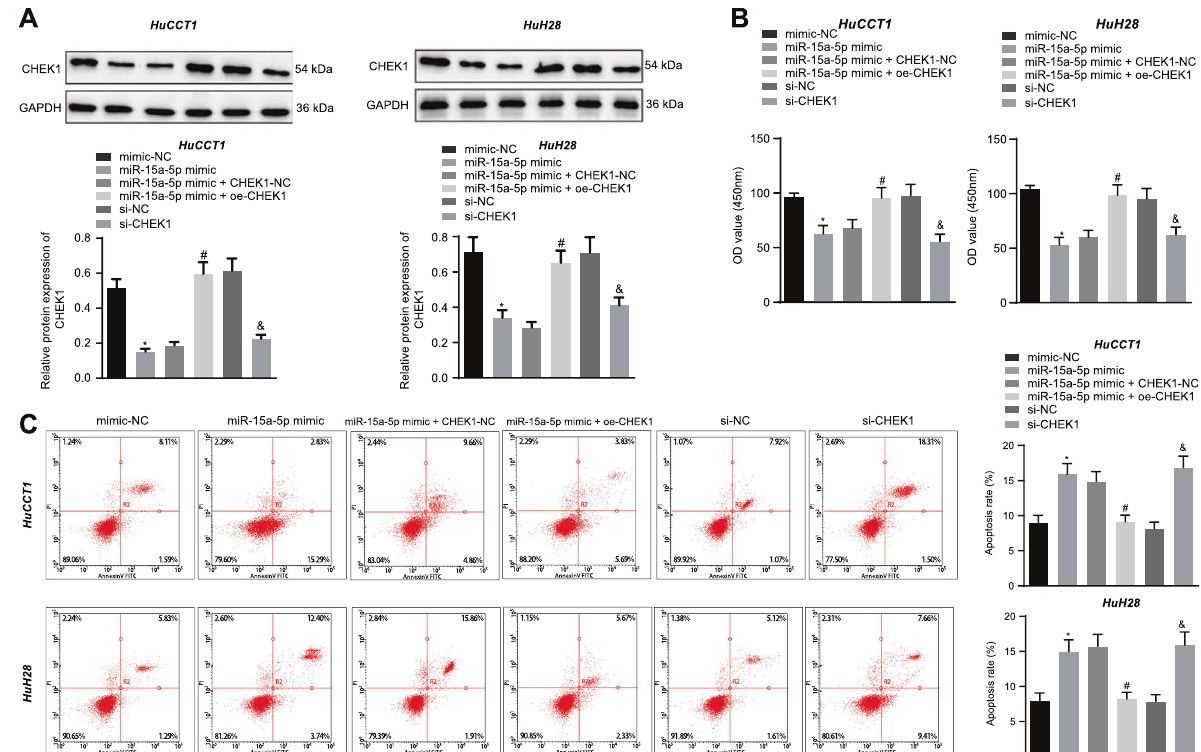
Fig. 3 miR-15a-5p promotes apoptosis and represses the proliferation of CCA cells by targeting CHEK1. A Western blot assay of CHEK1 protein in HuCCT1 and HuH28 cells. Quantitative results of protein bands are displayed at the top of the panel. B Proliferative analysis of HuCCT1 and HuH28 cells. OD value was assessed at 450 nm. C Apoptosis evaluation of HuCCT1 and HuH28 cells using fl ow cytometry. In panels A – C miR-15a-5p mimic, miR-15a-5p mimic + oe-CHEK1, si-CHEK1, and their corresponding controls were individually transfected into HuCCT1 and HuH28 cells. The data are presented as mean ± standard deviation. The values at multiple groups were compared using one-way ANOVA followed by Tukey ’ s post-hoc tests; *means comparison against the mimic-NC group, P < 0.05; # means comparison against miR-15a-5p mimic + CHEK1-NC group, P < 0.05; & means comparison against the si-NC group, P < 0.05. Cell experiments were repeated three times (Fig. 2B). Meanwhile, the results of RT-qPCR and Western blot assay revealed that compared to the mimic NC-treated HuCCT1 and HuH28 cells, miR-15a-5p mimic-treated HuCCT1 and HuH28 cells displayed increased levels of miR-15a-5p (Fig. 2C) but decreased mRNA and protein levels of CHEK1 (Fig. 2D). However, miR-15a-5p inhibitor-treated HuCCT1 and HuH28 cells displayed decreased levels of miR-15a-5p (Fig. 2C) but increased protein level of CHEK1 (Fig. 2D). These results demonstrate that miR-15a- 5p targets CHEK1 and reduces the level of CHEK1.